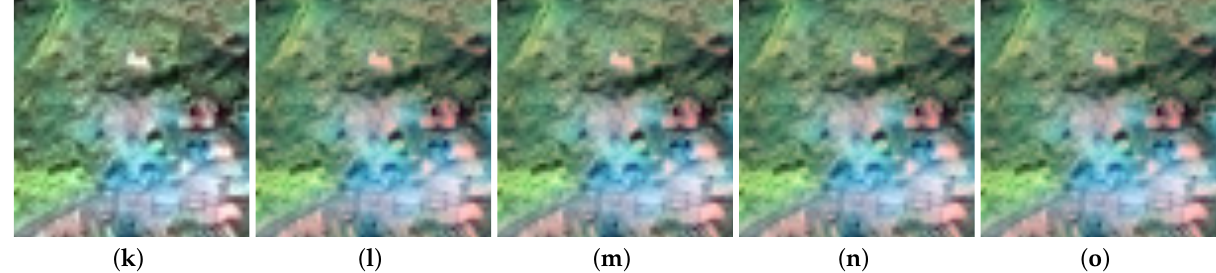
Figure 4. Close-ups of the fused results using the reduced resolution China dataset: ( a ) GT; ( b ) GSA; ( c ) MF-HG; ( d ) MBFE- BDSD-HPM; ( e ) MBFE-GSA-HPM; ( f ) FE-HPM; ( g ) GLP-HPM; ( h ) MBFE-BDSD-CBD; ( i ) MBFE-GSA-CBD; ( j ) FE-CBD;